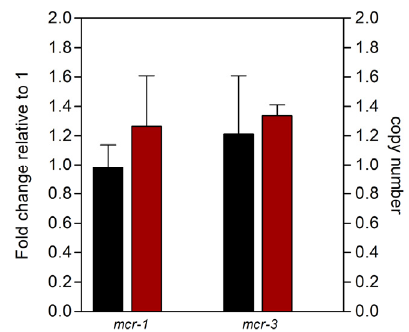
Figure 3. Functionality DNA constructs for mcr expression. Concentration (copy number) and messenger RNA (mRNA) expression from the different mcr gene constructs were determined by qPCR with primers mcr1q, mcr3q, and recAq (Table 1) on DNA or complementary DNA (cDNA) (see above) from the four recombinant clones. Firstly, mcr DNA concentration (black bars) and mcr gene expression (white bars) from all strains were relativized to recA DNA or recA mRNA, respectively; secondly, every two-gene construct was normalized with respect to its single mcr -gene reference.